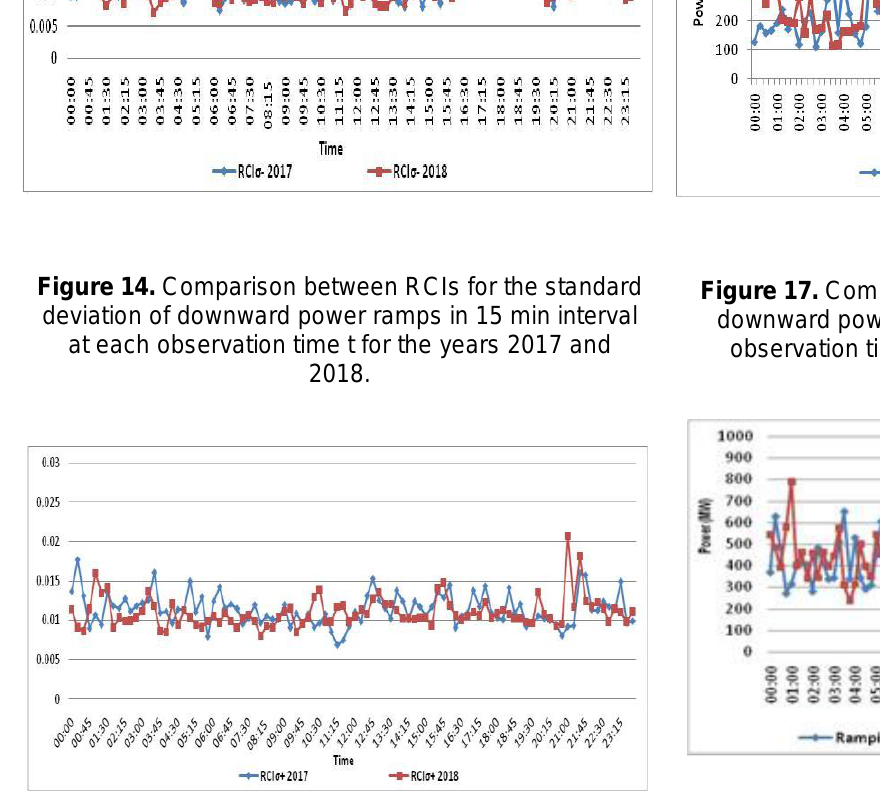
Figure 15. Comparison between RCIs for the standard deviation of upward power ramps in 15 min interval at each observation time t for the years 2017 and 2018.